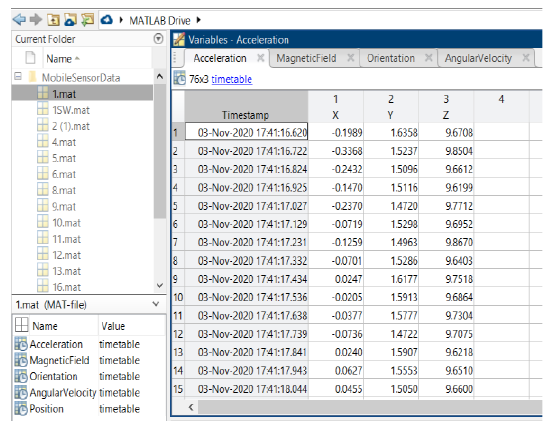
Figure 36. Extracted smartphone sensor datasets.